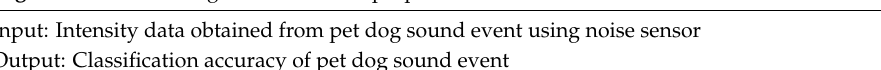
Algorithm 1 Overall algorithm with the proposed method.